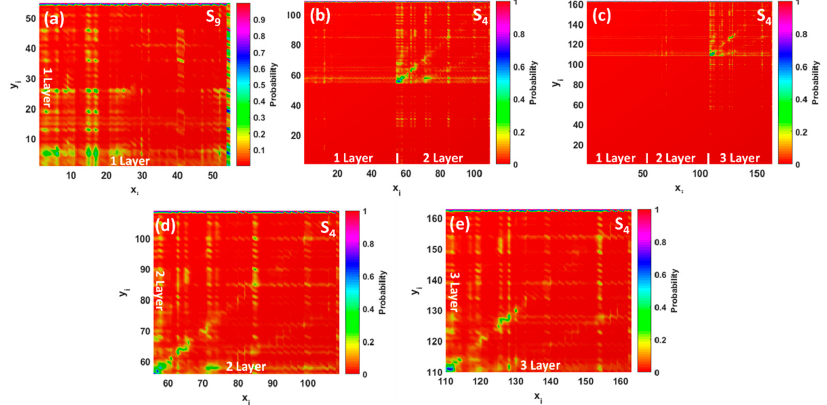
Figure 7. Two-dimensional representations of the simulated transition density matrix corresponding to the lowest excited states in thickness-varying GQDs after interaction with Pb: ( a ) Pb on monolayer (1ML), ( b ) Pb on bilayer (2ML), and ( c ) Pb on trilayer (3ML) GQDs, respectively. ( d , e ) demonstrate zoomed transition density matrix (TDM) patterns for S 4 excited states in bilayer and trilayer GQDs interacting with Pb. Since the oscillator strengths of the main electronic transitions in Pb GQDs are small, the corresponding TDM patterns were normalized by the maximal value of the probability of finding the generated electron-hole pairs. Colour bars are given on the right.